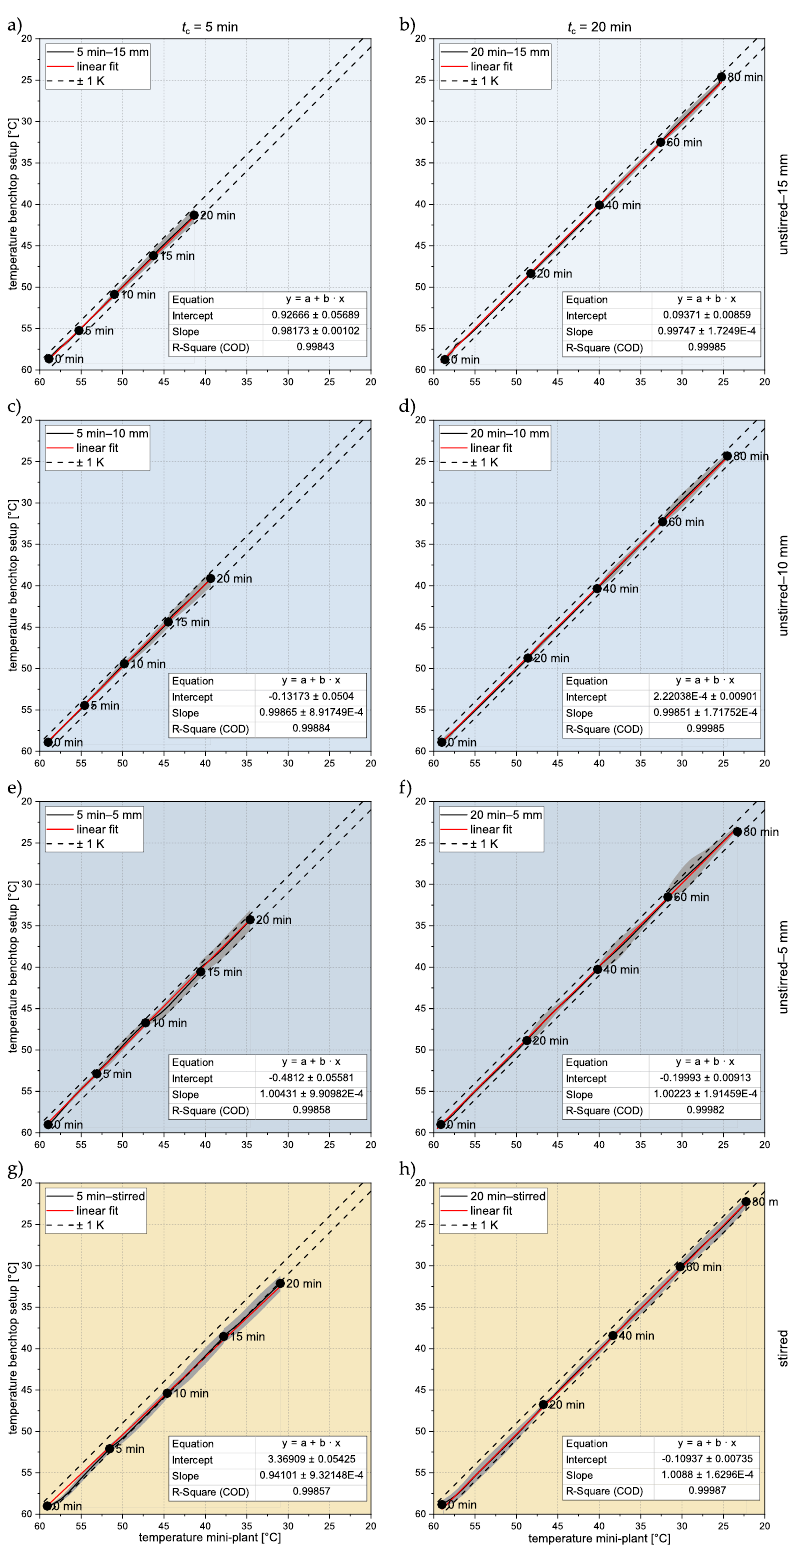
Figure 5. Parity plots of the temperature profiles on the mini-plant plotted against the profiles of the benchtop setup. Since the temperature of the process is decreasing over time, the axes values are decreasing from left to right and bottom to top, respectively. The dotted lines are ± 1K from x = y . Each of the experiments was performed in a fourfold manner. The standard deviations are